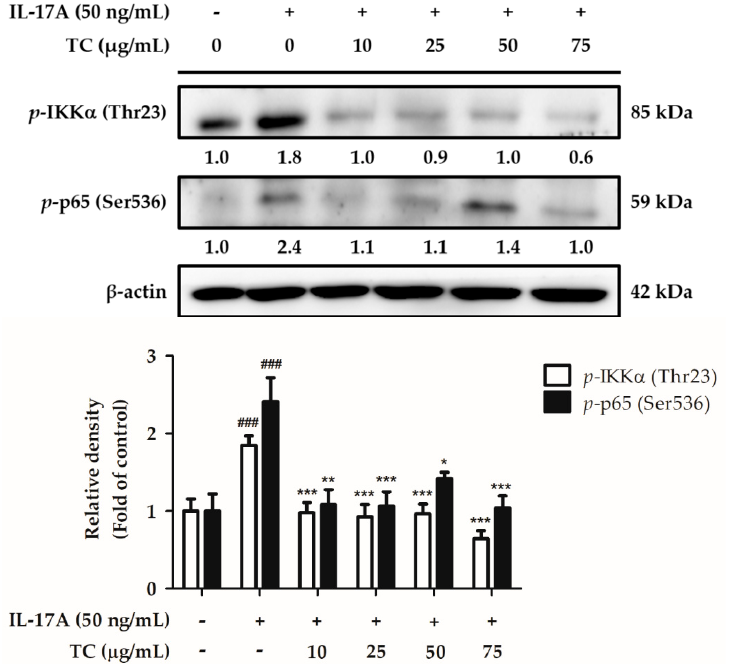
Figure 10. TC inhibits IL-17A-induced expression of pro-inflammatory proteins related to the NF- κ B signaling pathway in human keratinocytes. TC could inhibit IL-17A-induced NF- κ B expression in human keratinocytes, thereby possibly suppressing inflammatory responses. Significant differences between treated groups were evaluated. ### p < 0.001 compared to the control group. * p < 0.05; ** p < 0.01; *** p < 0.001 compared to the IL-17A-induced group.